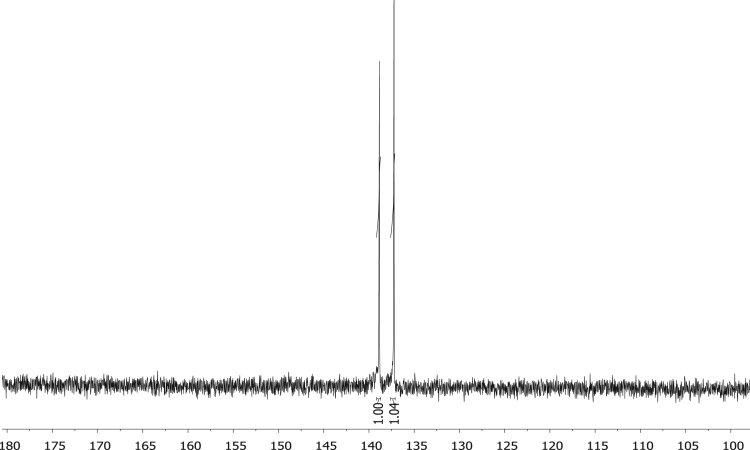
31P NMR of [Rh(acac)CO(C6H4OPPh2)], 4.